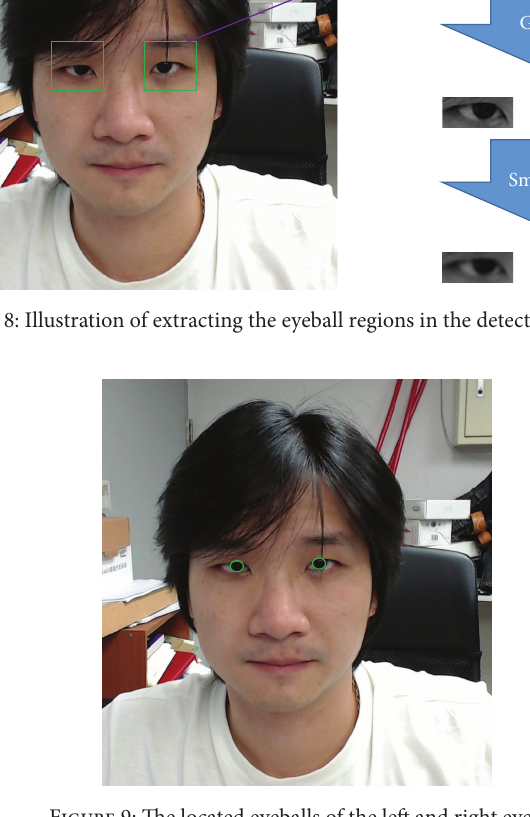
Figure 9: The located eyeballs of the left and right